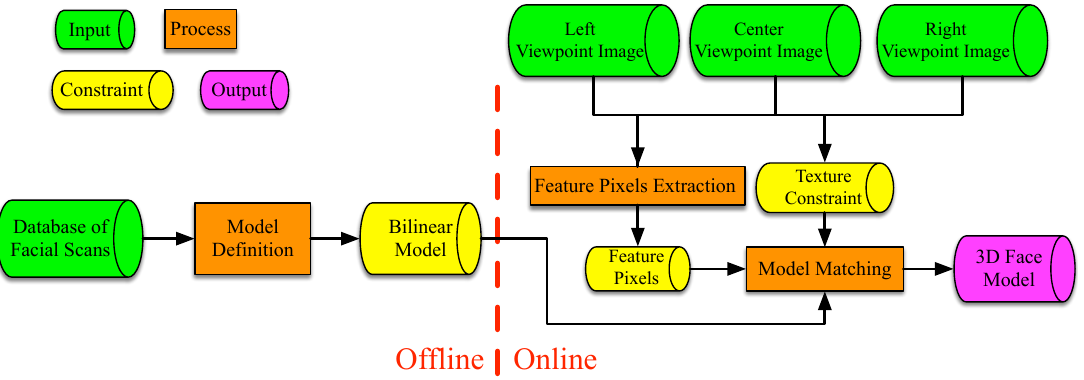
Figure 1. The conceptual flow diagram of the proposed